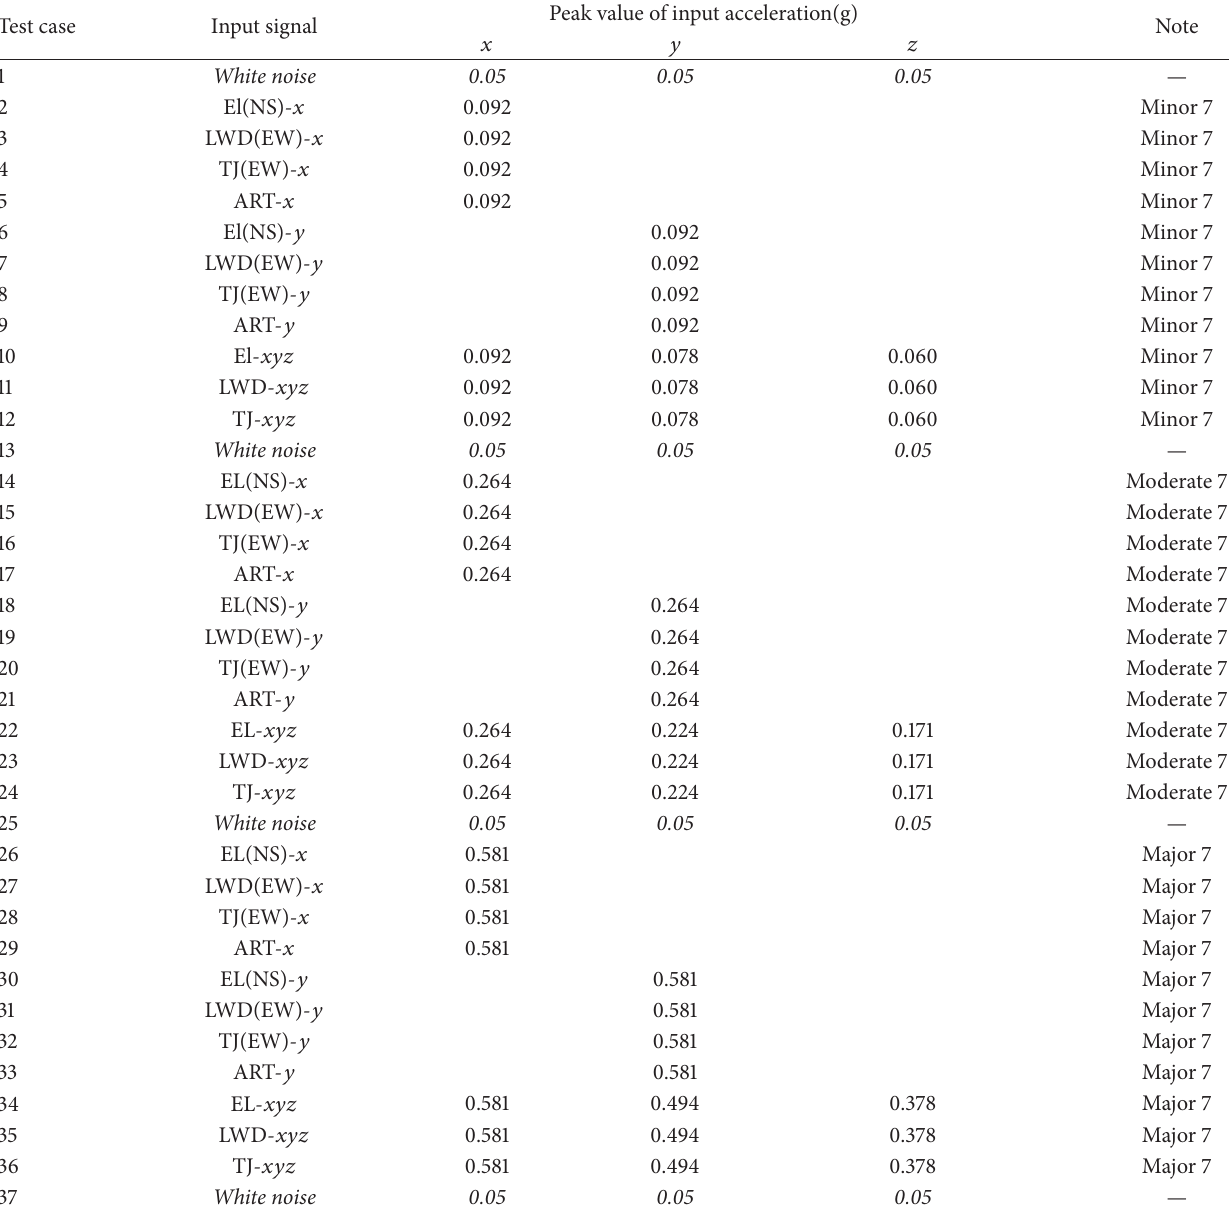
Table 11: Test program for the base-fixed